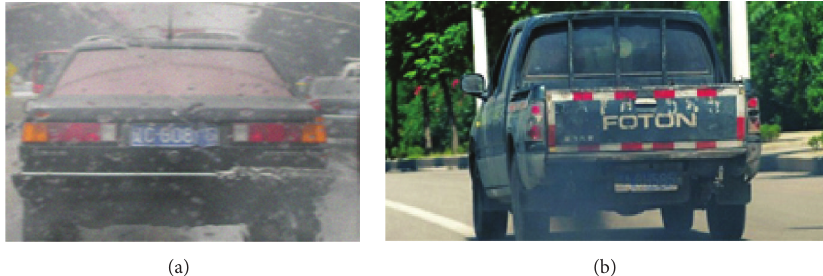
Figure 16: One of the LR plate images in the case of (a) rain and fog weather and (b) black vehicle exhaust.